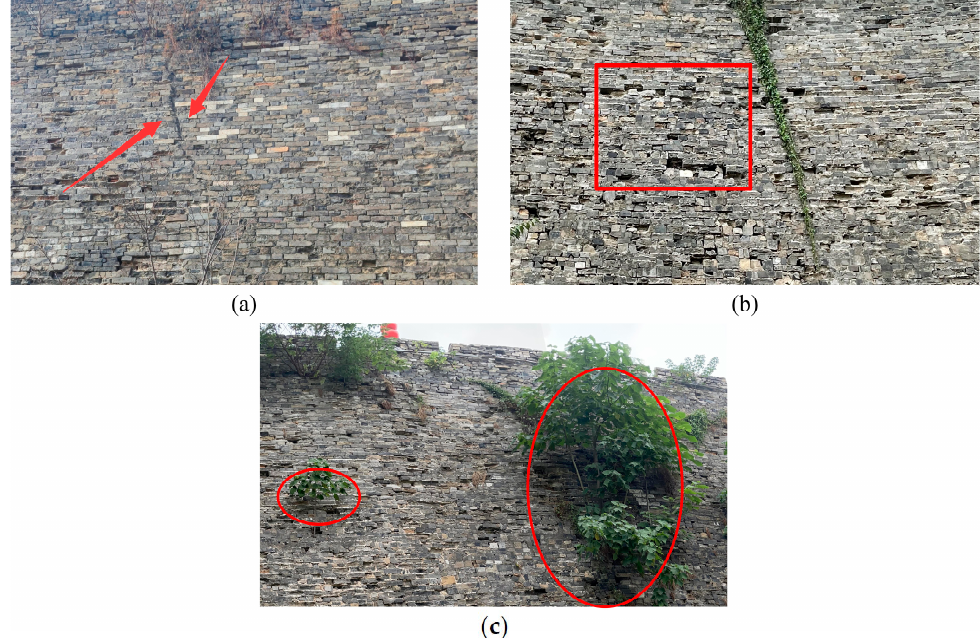
Figure 2. Various defects of city wall: ( a ) cracks; ( b ) wall shedding; ( c ) damage by vegetation growth.